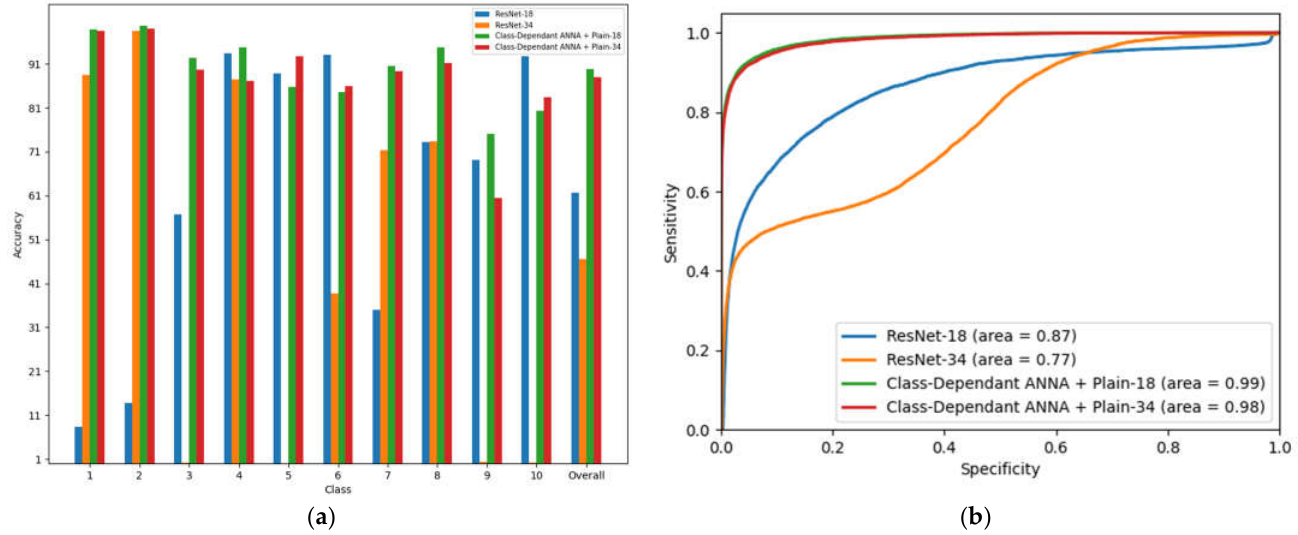
Figure 14. Comparison of ResNet and class-dependent ANNA. ( a ) Overall accuracy and per-class accuracies achieved by ResNet and class-dependent ANNA on MNIST dataset; ( b ) ResNet and class-dependent ANNA ROC curves on MNIST dataset.